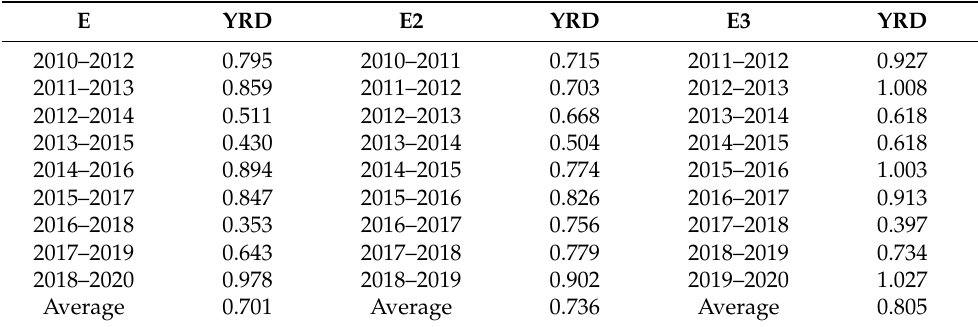
Table 5. Distribution of Different Efficiencies in YRD region. E YRD E2 YRD E3